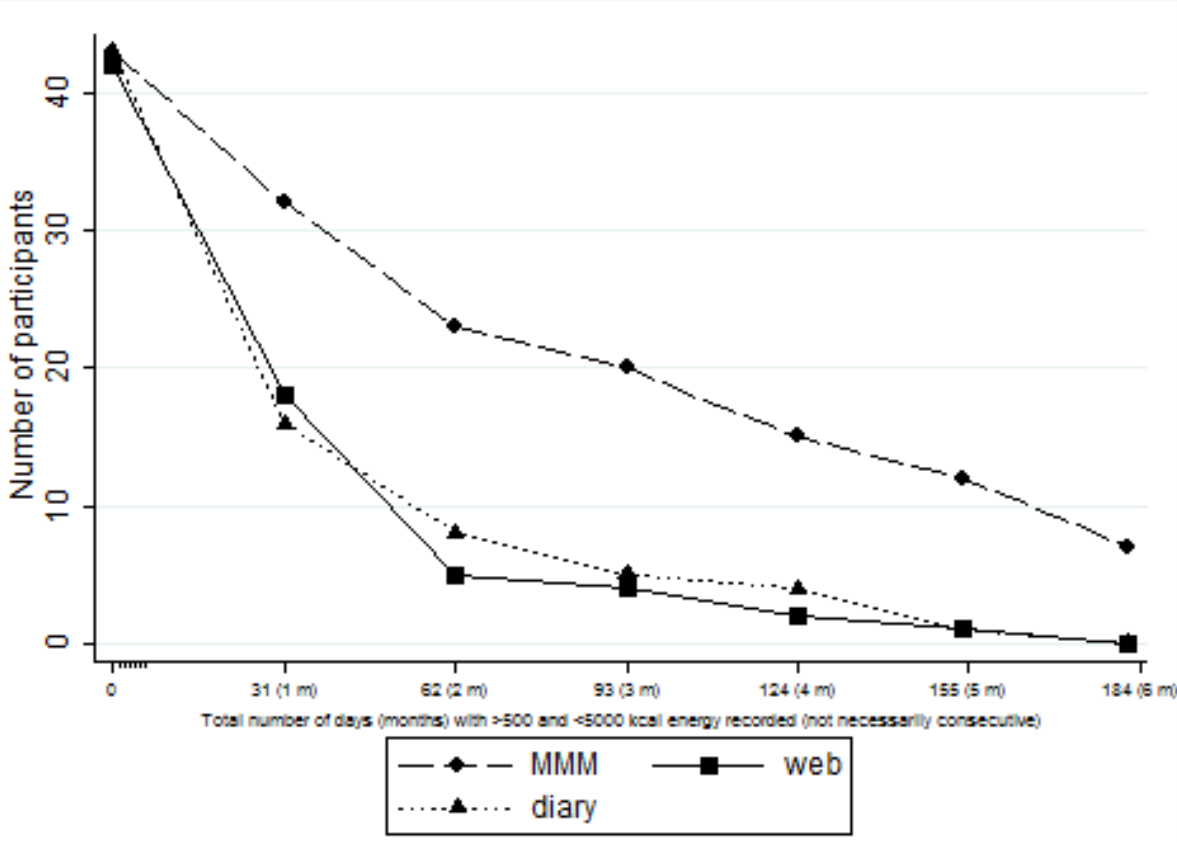
Figure 4. Intervention use in a randomized 3-arm pilot trial (N=128) of My Meal Mate (MMM). Adherence to the intervention arms (smartphone application, website, and diary) over the trial duration (6 months) is shown by total number of days completed in each intervention group. Data collection was conducted between May to December 2011 (total 184 days for each participant in the trial). A complete day is considered to be one with ≥ 500 kcal and ≤ 5000 kcal energy recorded. Intervention use is for overall total days completed and not necessarily consecutive